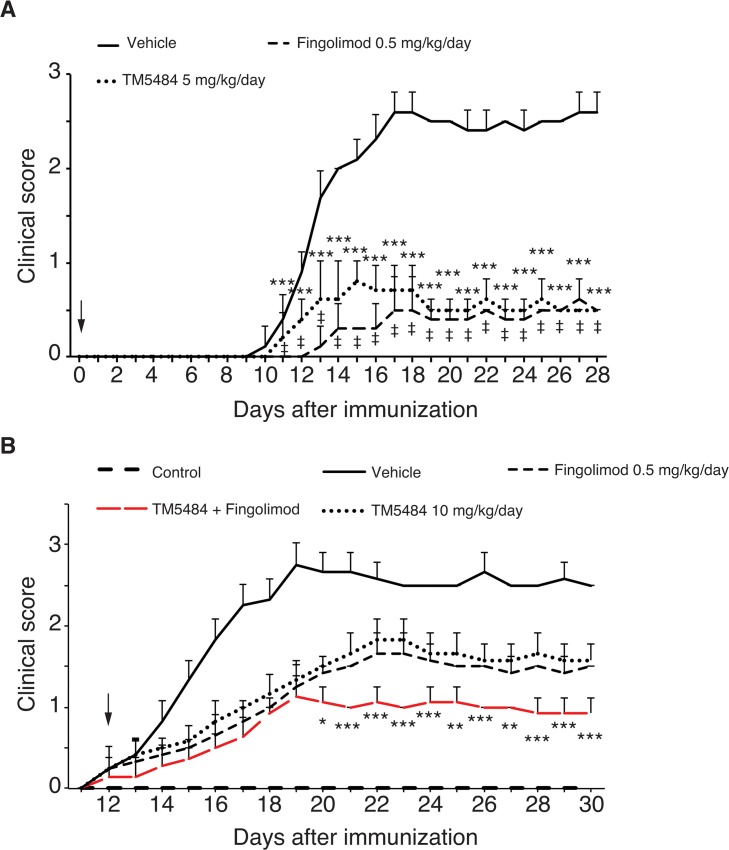
Clinical score (Preventive and combined therapy).Mice were injected with myelin oligodendrocyte glycoprotein35-55 peptide in an equal volume of complete Freund’s adjuvant. A, Administration of TM5484 (5 mg/kg/d) from day 0 not only abolished paralysis but also delayed the onset of symptoms in EAE mice. **P<0.01 or ***P<0.001 Vehicle vs TM5484, †P < 0.01, ‡P < 0.001 Vehicle vs Fingolimod by 2-way ANOVA and Bonferroni test, n = 8–10. B, Simultaneous administration of TM5484 (10 mg/kg/d) with fingolimod (0.5 mg/kg/d) attenuates the clinical score to a significantly greater extent than either TM5484 or fingolimod alone. Data are shown as the means and corresponding SEM. *P<0.05 or ***P<0.001 Fingolimod vs TM5484 + Fingolimod, by 2-way ANOVA and Bonferroni test, n = 8–10.